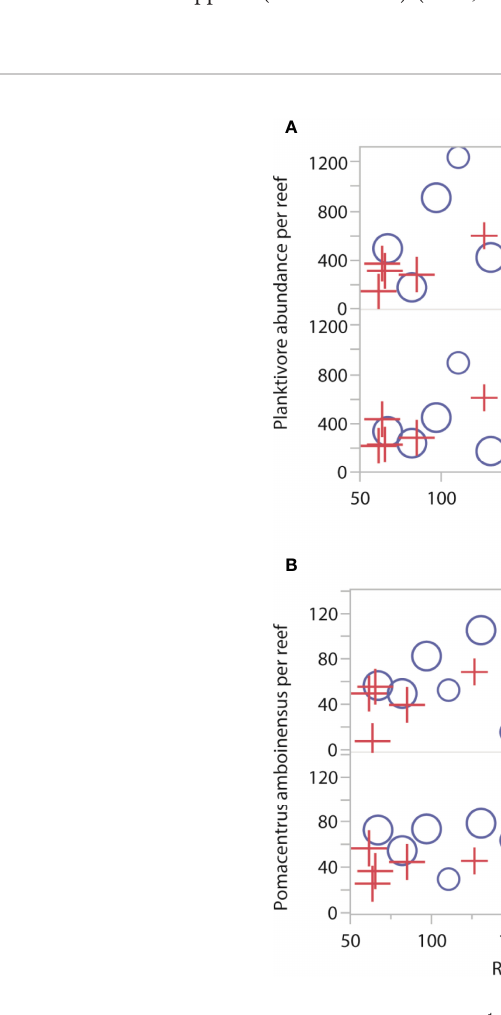
FIGURE 1 | Abundance of planktivorous Pomacentridae fi sh (reef -1 ) according to cleaner fi sh Labroides dimidiatus presence treatment (Control = yes cleaner fi sh present, Removal = no cleaners present), Casuarina Beach (small symbols) or Lagoon site (large symbols), reef area, and sampling year for (A) total abundance and (B) Pomacentrus amboinesis